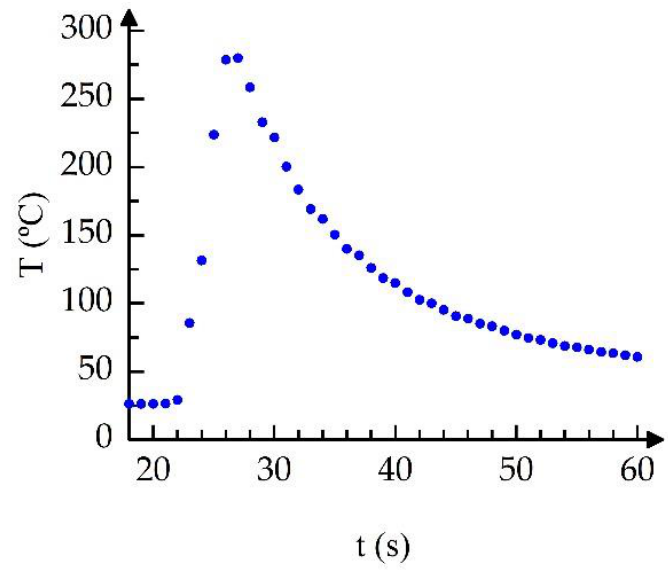
Figure 1. Heating-cooling curve of the targets Fe-4.10 and 7.25 at.% Mn .